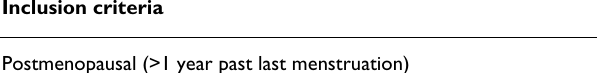
Table 1: Eligibility